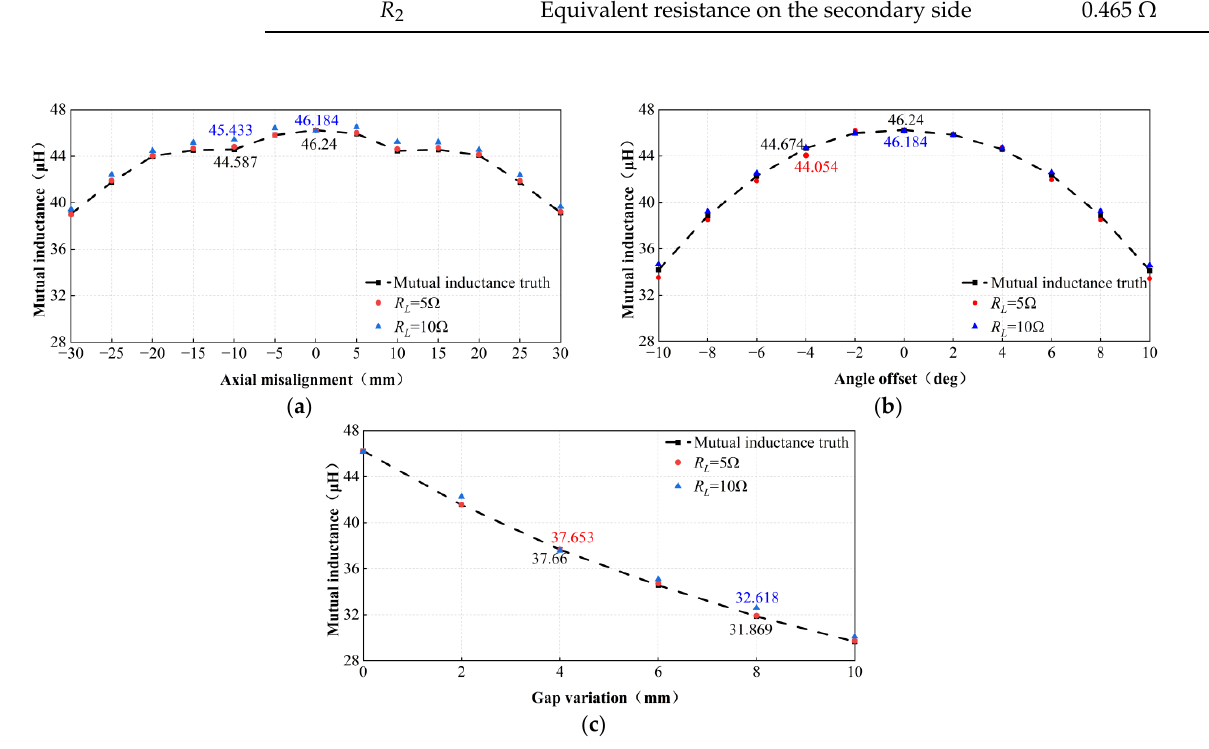
Figure 14. Results of mutual inductance identification for different loads and three-dimensional misalignment. ( a ) Axial misalignment; ( b ) Angle offset; ( c ) Gap variation. misalignment. ( a ) Axial misalignment; ( b ) Angle offset; ( c ) Gap